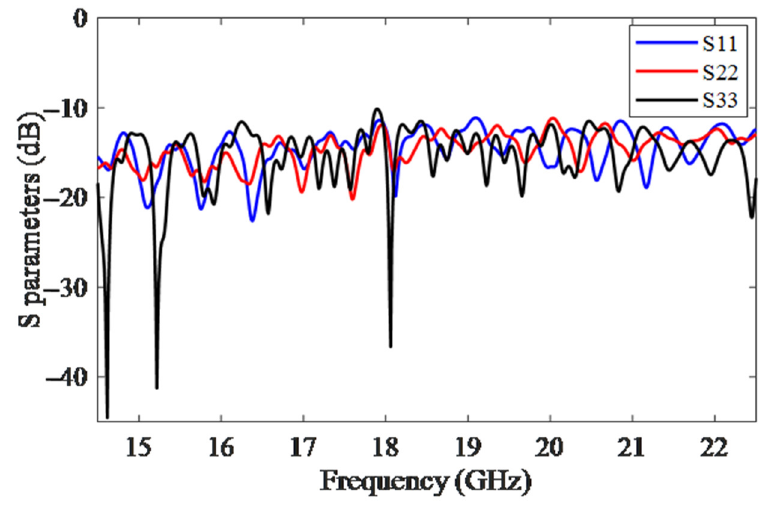
Figure 13. The measured return losses of 2D-MBA for different beam ports.